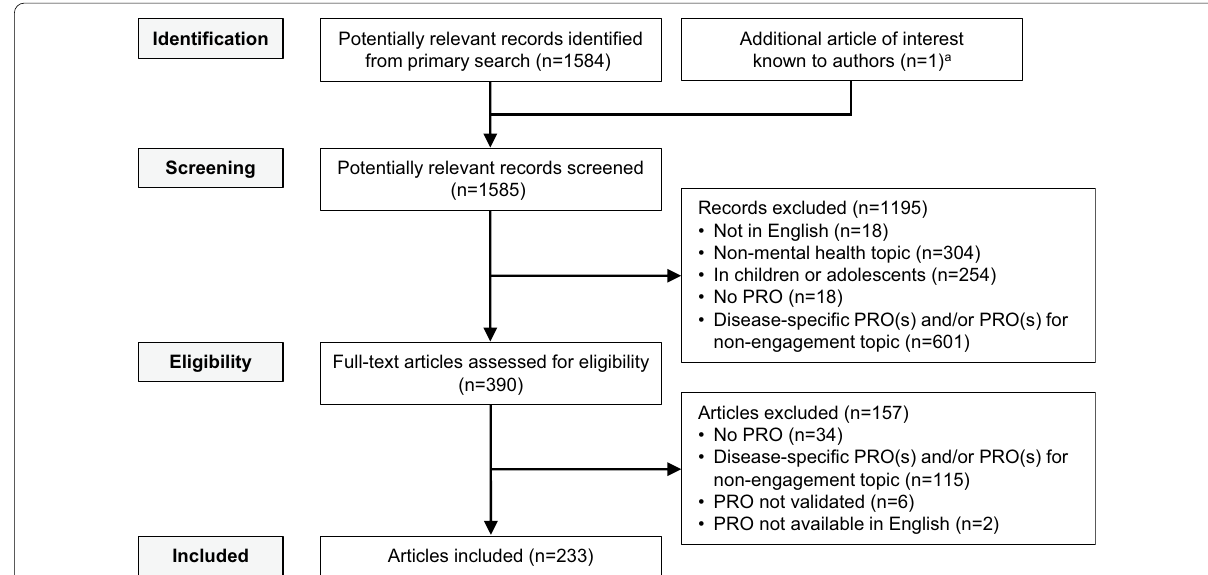
Fig. 1 PRISMA flow diagram. a This article, describing the Life Engagement Test, was not picked up by the search terms due to a lack of detail in the article’s title and abstract. PRO: patient-reported